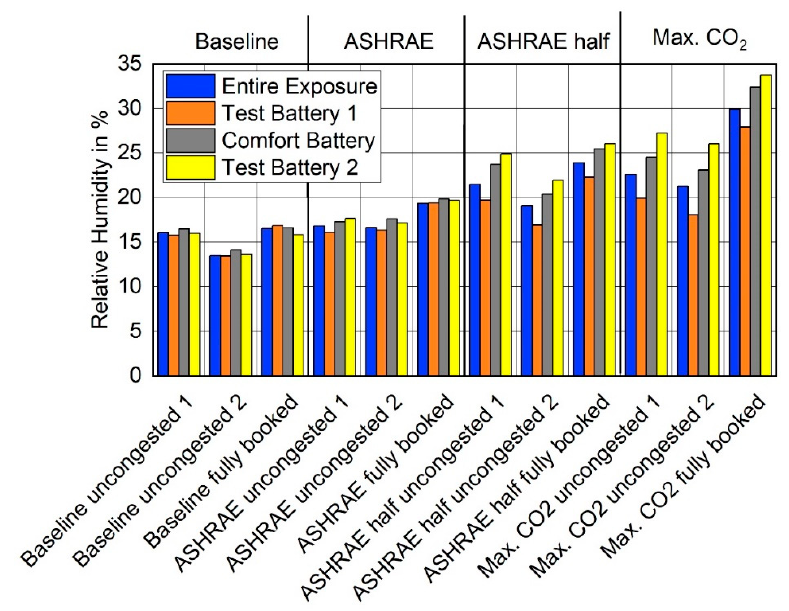
Figure 9. Measured average relative humidity in the cabin.